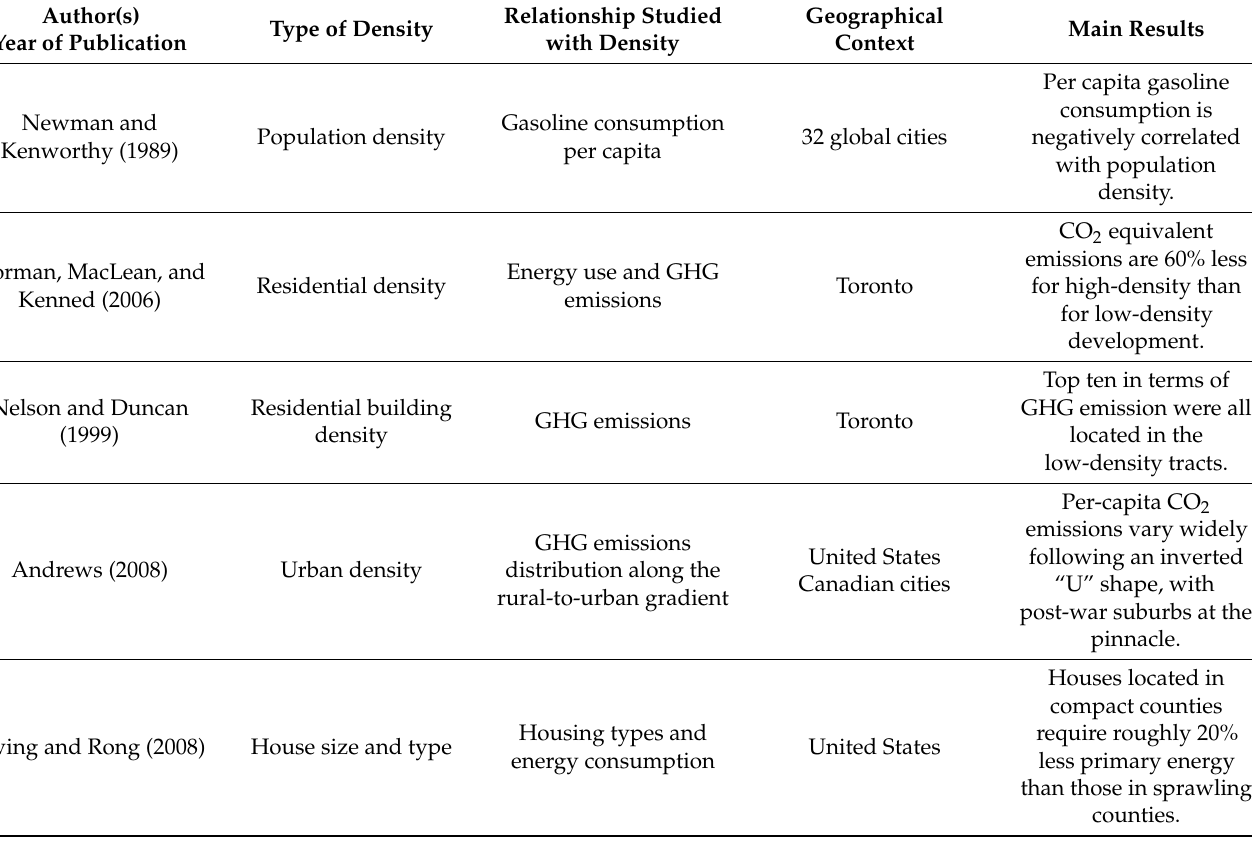
Table 4. The impacts of urban density on fossil energy consumption and GHG/CO 2 emissions [36] (p.